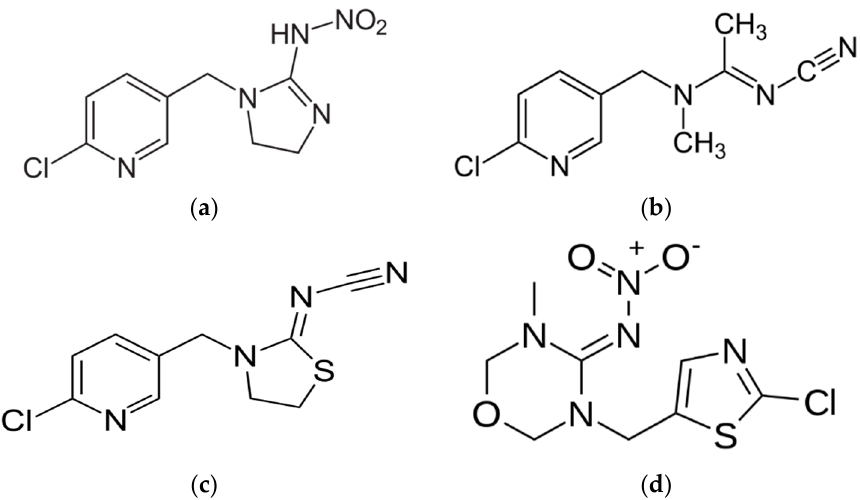
Figure 2. Molecular structures of neonics examined in this work. ( a ) Imidacloprid; ( b ) Acetamiprid; ( c ) Thiacloprid; and ( d ) Thiamethoxam.